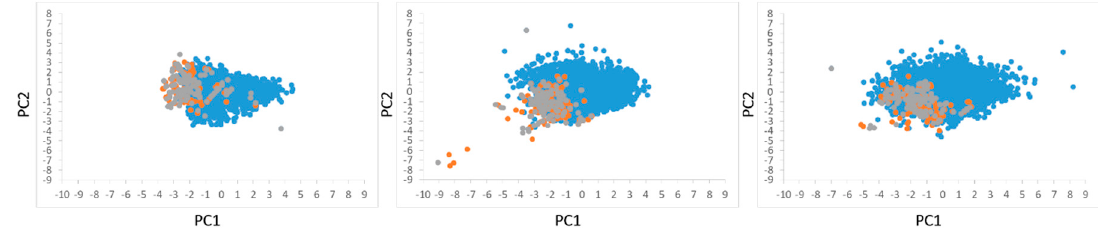
Figure 1. Principle Component Analysis (PCA) plots of training set (orange), validation set (grey) and test set 1 (blue) compounds in the space of the descriptors comprising the 7-descriptors model ( left ), 10-descriptors model ( middle ) and 13-descriptors model ( right ) for the M2 dataset. The first two PCs cover 49%, 42%, and 35% of the original variance for the 7-descriptors, 10-descriptors, and 13-descriptors models, respectively.